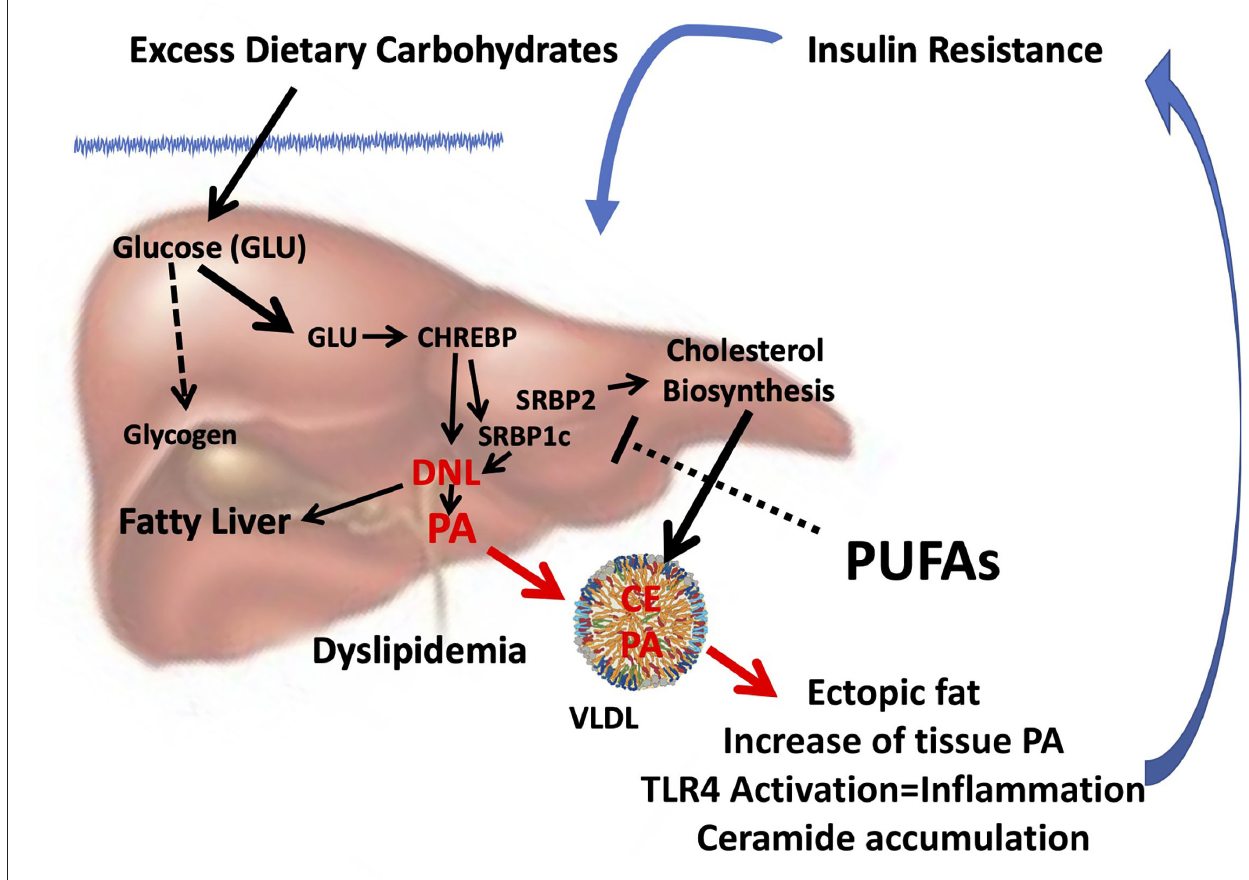
FIGURE 1 | Combined consequences of liver insulin resistance and reduced PUFA intake. Insulin resistance in the liver is characterized by hyperinsulinemia and a reduced ability to store glycogen. In the presence of excess glucose, CHREBP is activated which, in turn, together with hyperinsulinemia, induces SREBP1c, and synergistically induces DNL (124) and thereby the biosynthesis of endogenous PA. Reduced PUFA intake can further promote PA and cholesterol biosynthesis since PUFAs inhibit both SREBP1c (123) and SREBP2 (125). Enhanced DNL can cause fatty liver and formation and release of VLDL enriched with PA and cholesterol esters. As a result, the accumulation of ectopic fat occurs in different tissues, and the increase in tissue PA can sustain insulin resistance by inducing inflammation through the activation of TLR4 (105) and accumulation of ceramides (106), setting in motion a vicious circle. Because reduced PUFA intake is often associated with an unbalanced increase in dietary SFA/PUFA, the rise in tissue PA can be mistakenly attributed to its dietary intake. CHREBP, carbohydrate-responsive element-binding protein; SREBP, sterol regulatory element-binding protein; DNL, de novo lipogenesis; PA, palmitic acid; PUFA, polyunsaturated fatty acid; TLR4, toll-like receptor 4; SFA, saturated fatty